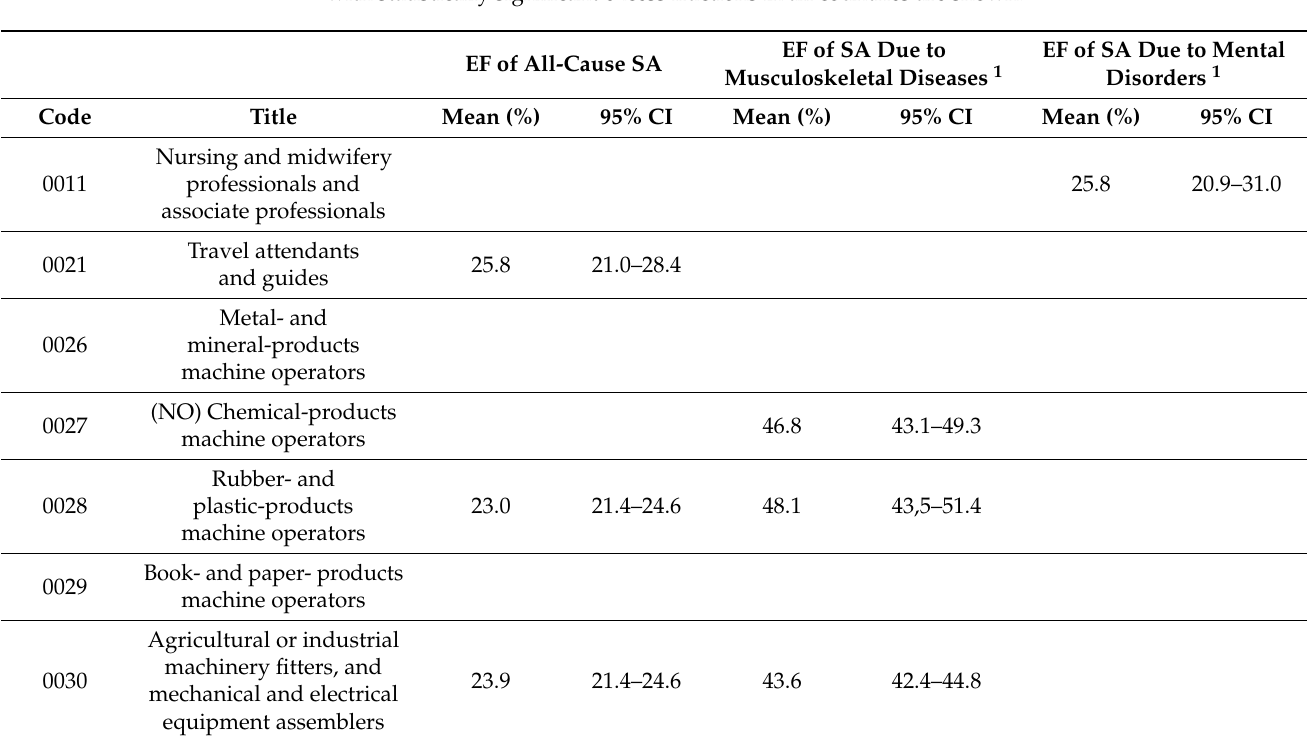
Table 8. Weighted means of country-specific excess fractions (EF, %) of the age-adjusted one-year cumulative incidence of prolonged sickness absence (SA) among women. Only occupational groups with statistically significant excess fractions in all countries are